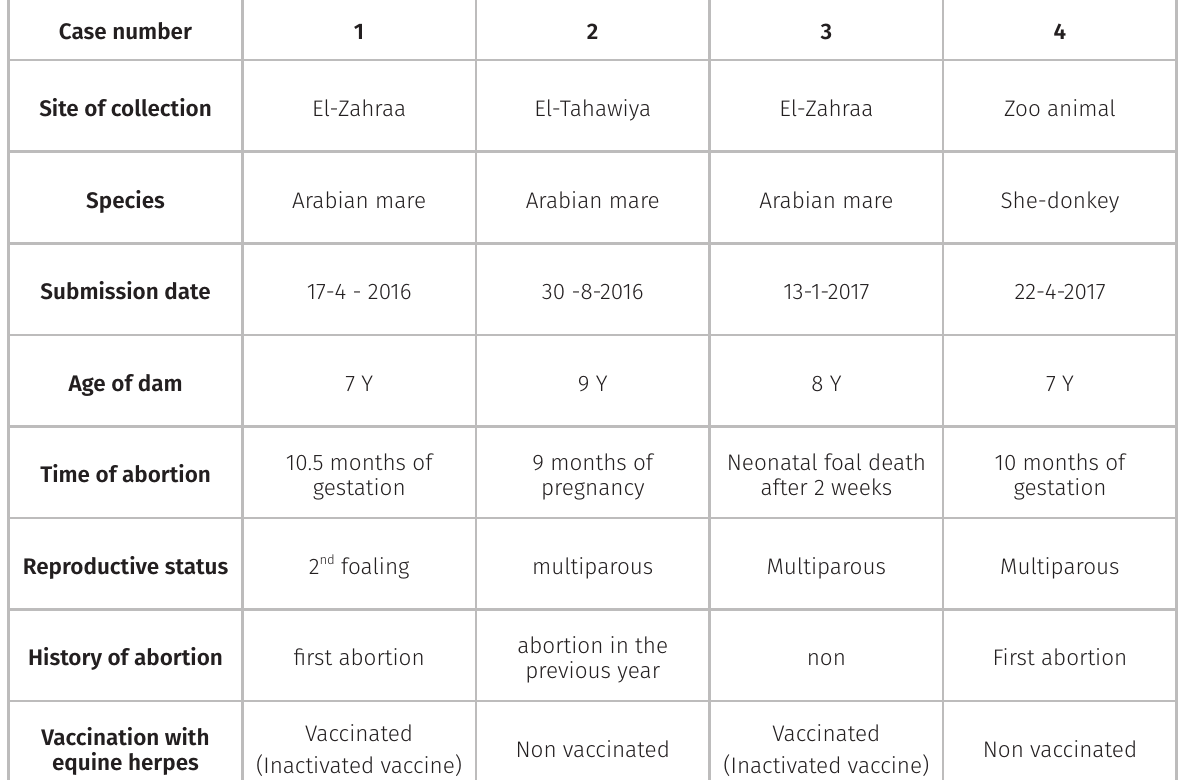
Table I. History of aborted cases and neonatal